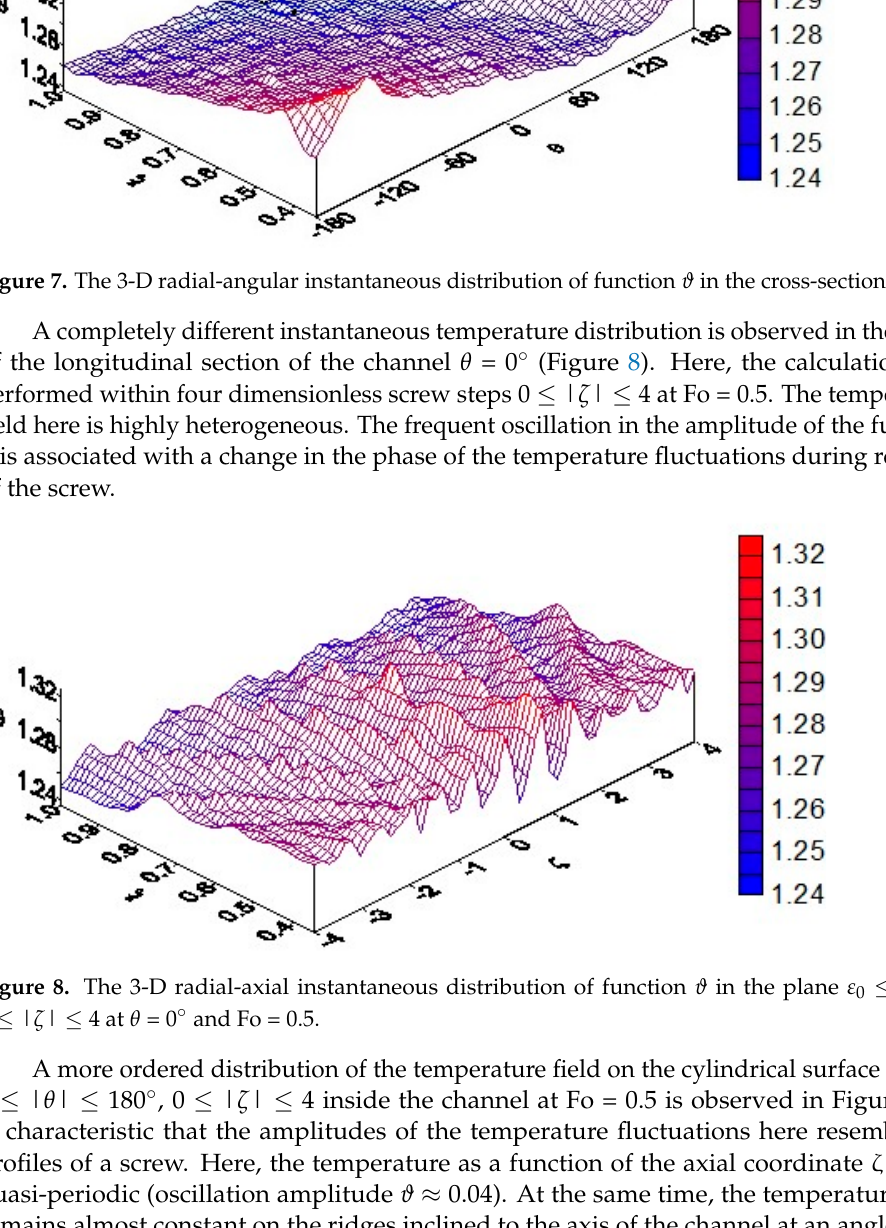
Figure 8. The 3-D radial-axial instantaneous distribution of function ϑ in the plane ε 0 ≤ ξ ≤ 1, 0 ≤ | ζ | ≤ 4 at θ = 0° and Fo = 0.5.